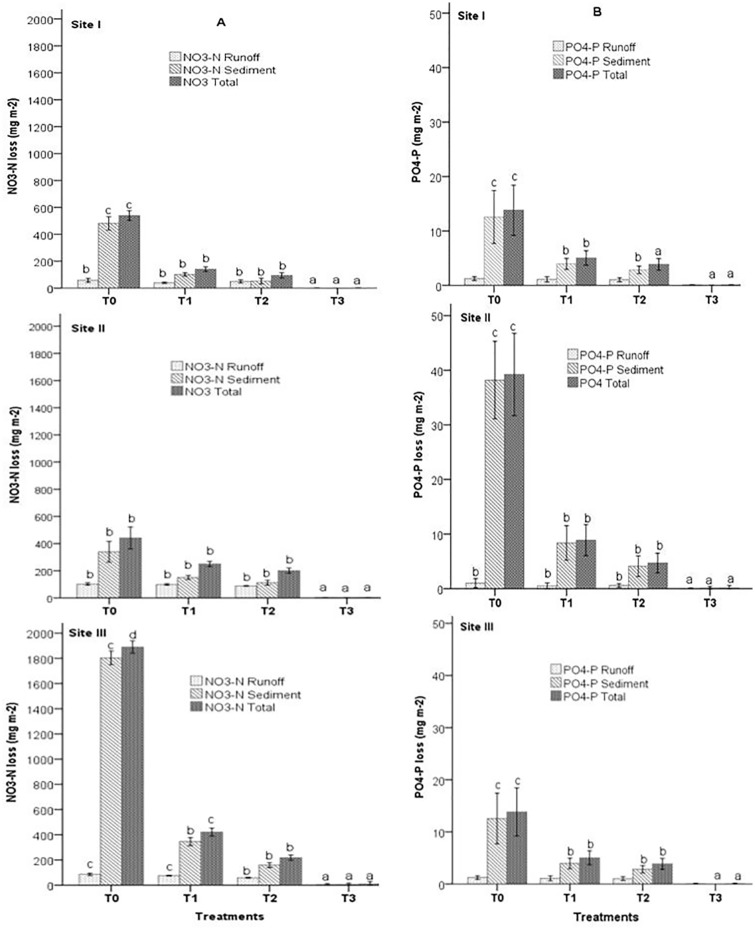
Annual losses of (A) NO3-N and (B) PO4-P in the eroded soil and runoff for the various treatments.Different letters indicate significant differences (Dunnett’s T3 test) within the same site and category (P<0.05): a<b<c<d. Error bars are standard deviation. See Table 2 for treatment descriptions. Short title: Annual losses of NO3-N and PO4-P in the eroded soil and runoff.